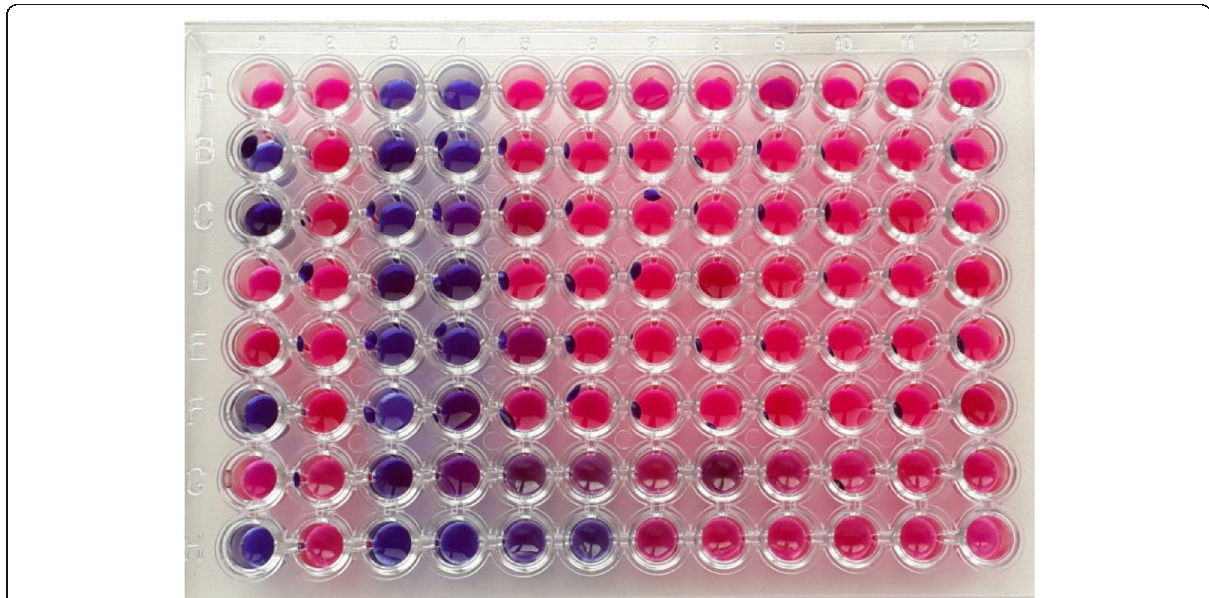
Fig. 6 Antibacterial activity using MIC of nano hybrid particles